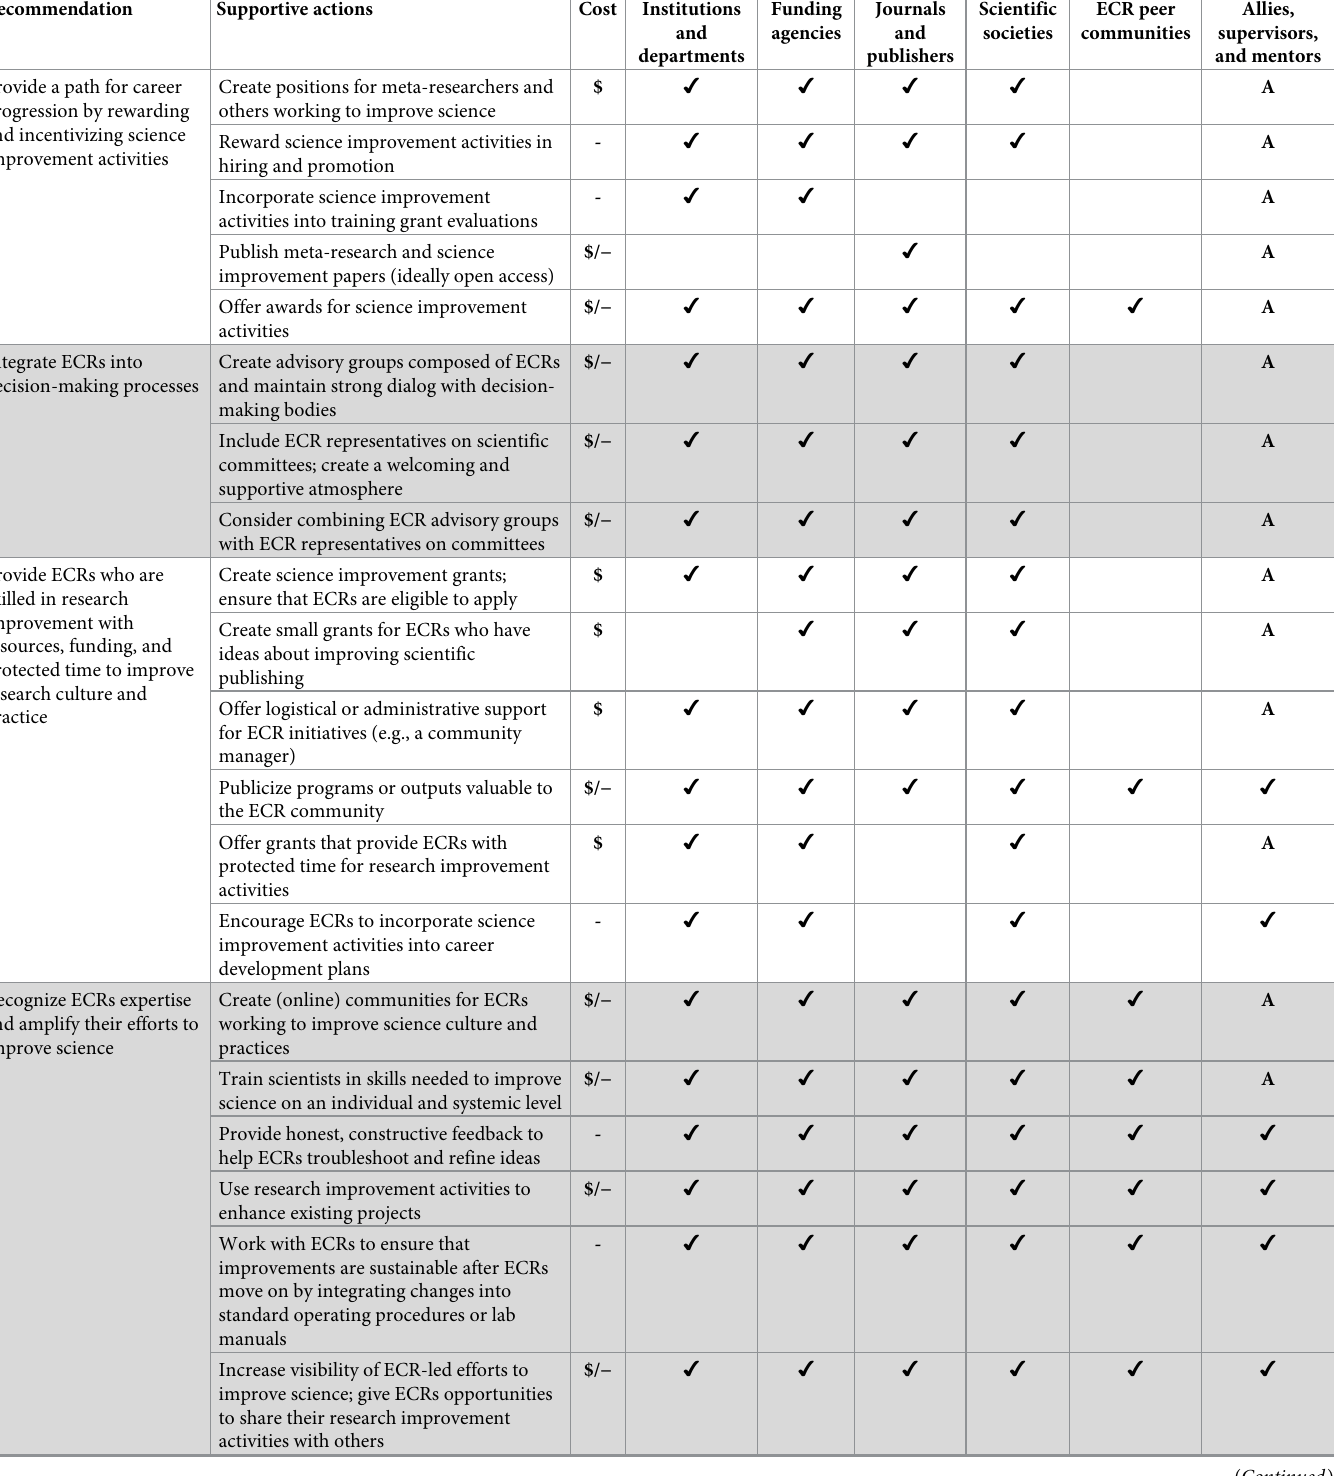
Table 1. Actions that organizations and individuals can take to support ECRs in improving science publishing and research culture. Recommendation